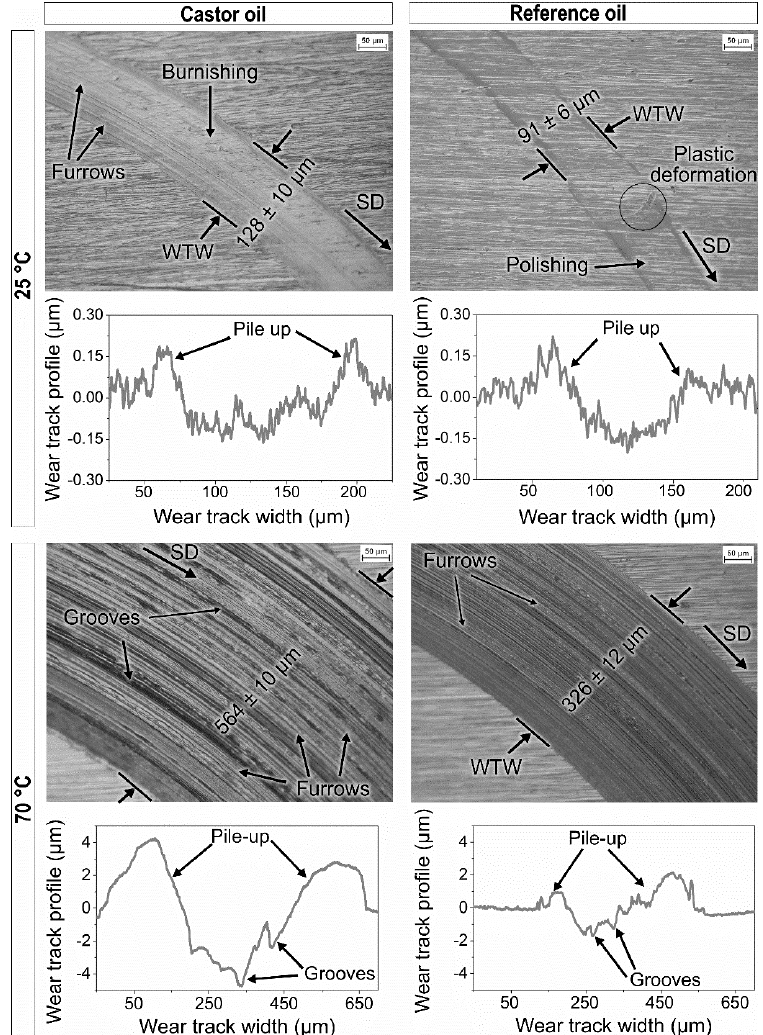
Figure 6. Optical micrographs at 200X of the wear track and wear track profiles on AISI 4140 vs. WC after friction tests lubricated with Castor and Reference oil at 25 and 70 °C. SD: Sliding direction.